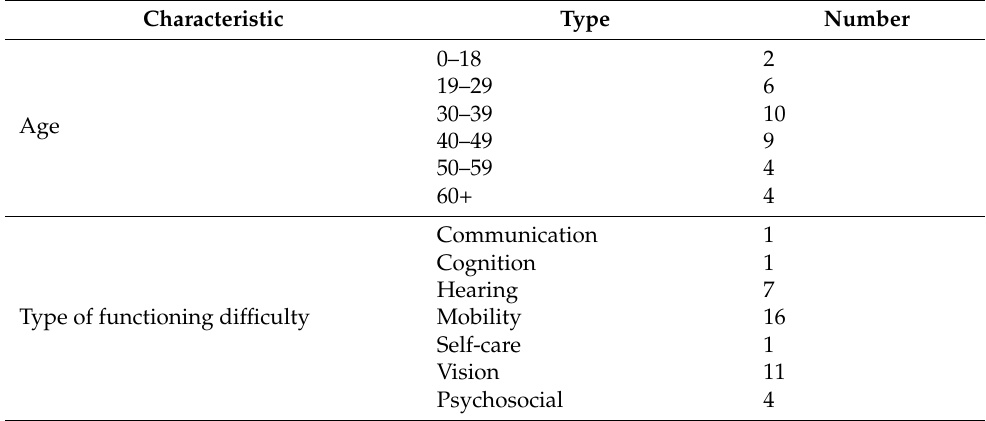
Table 2. Respondent ages and types of functional